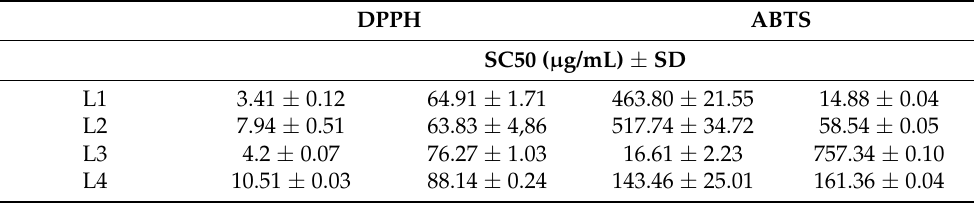
Table 3. Antioxidant capacities of Siparuna muricata EOs.